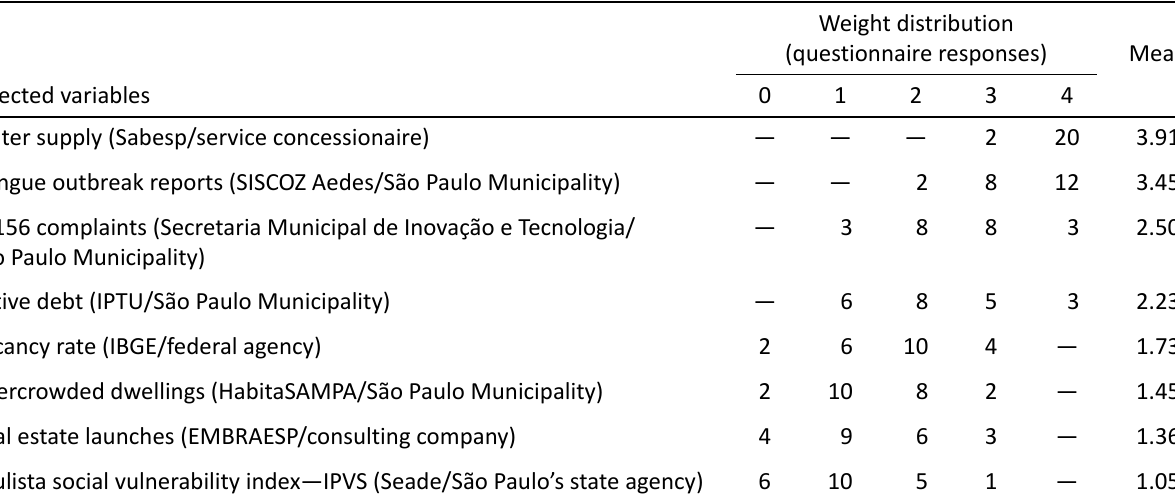
Table 2. Distribution of variables’ weights according to questionnaire